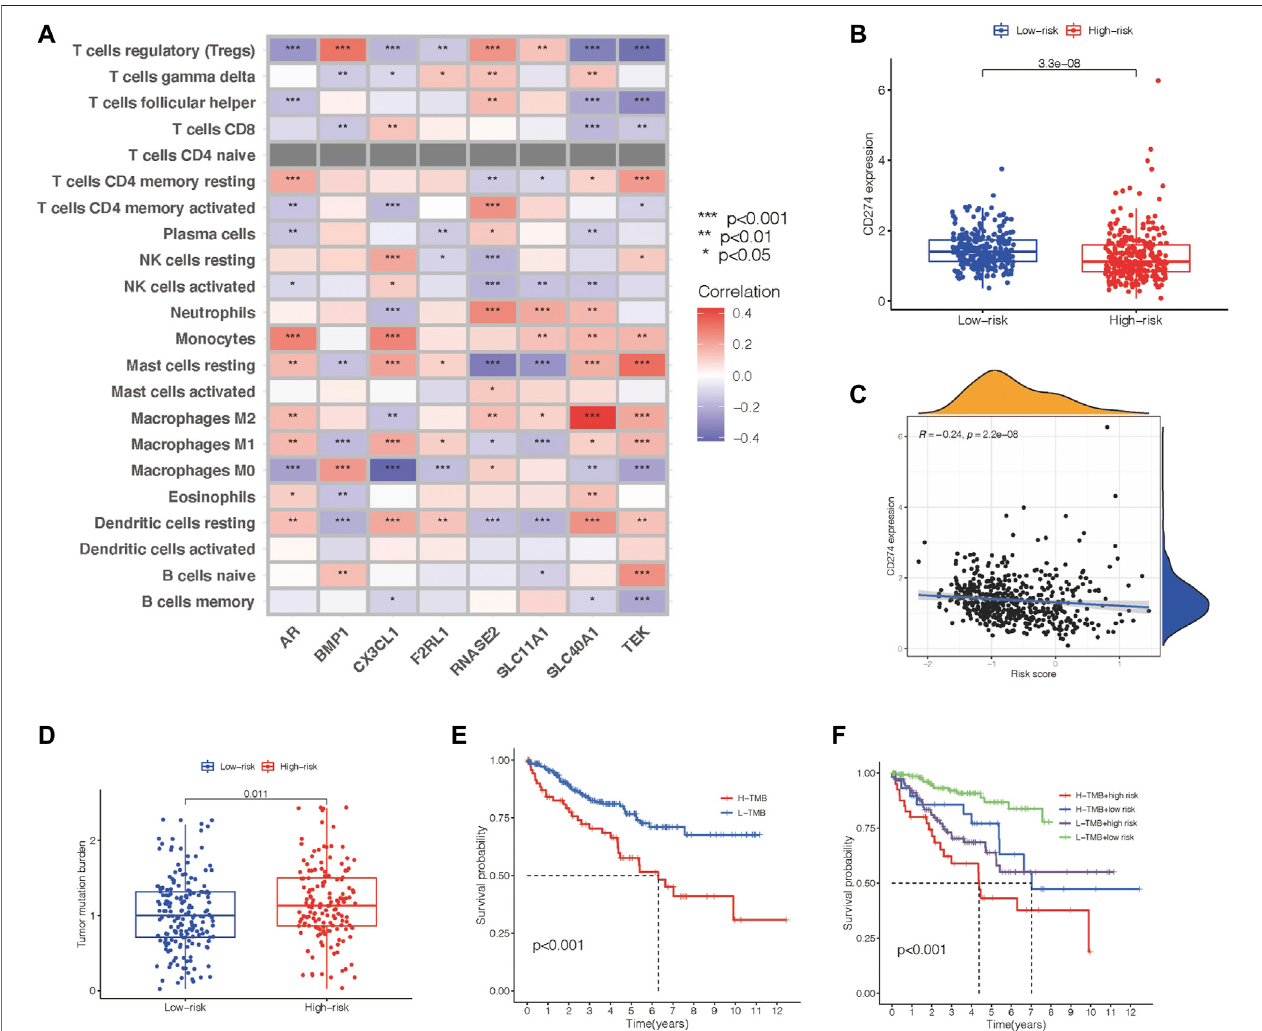
FIGURE 5 | Identi fi cation of the communication between the prognosis gene panel and immune associated features. (A) Heatmap showing the relationship of the prognosispanel withimmunecompositions. (B) Scatter plotsdraw arelationship between the prognosis panel and gene expression of CD274. (C) Scatter plots draw a relationship between the prognosis panel and gene expression of CD274. (D , E) TMB of each group and their association with survival time. (F) Kaplan – Meier survival analysis of the prognosis gene panel accompanied with the TMB value.